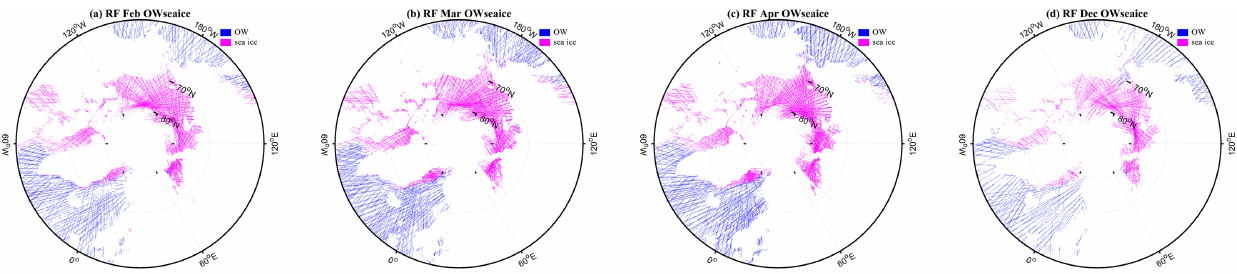
( c ) November, and ( d ) December are used as the test set in turn.